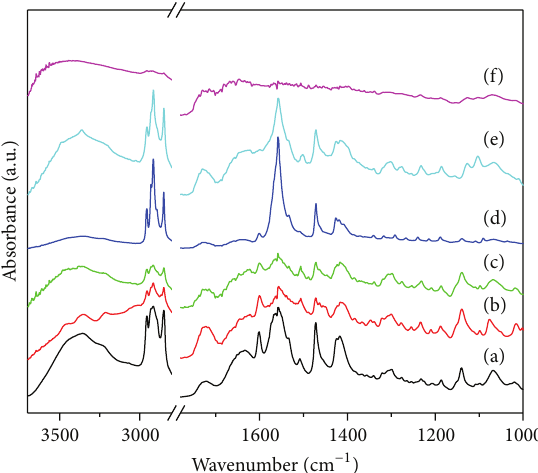
Figure 3: X-ray diffraction patterns of xerogels: (a) and ((c)– (f)): C18-Azo, C16-Azo, C14-Azo, C18-Azo-Me, and C16-Azo-Me in ethanolamine, respectively; (b) C16-Azo in nitrobenzene.